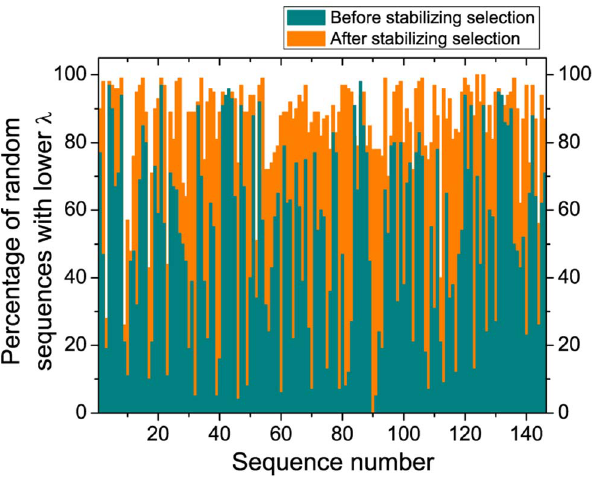
Figure 5. Stabilizing selection increases robustness of se- quences. The percentage of the random sequences having lower fraction of 1-step neutral mutants among all 1-step mutants ( l ) than the original sequence (green bars) and the best sequence after 5000 generations of stabilizing selection (orange bars). Sequences are ordered according to their length. Exact l are given in Table S1.